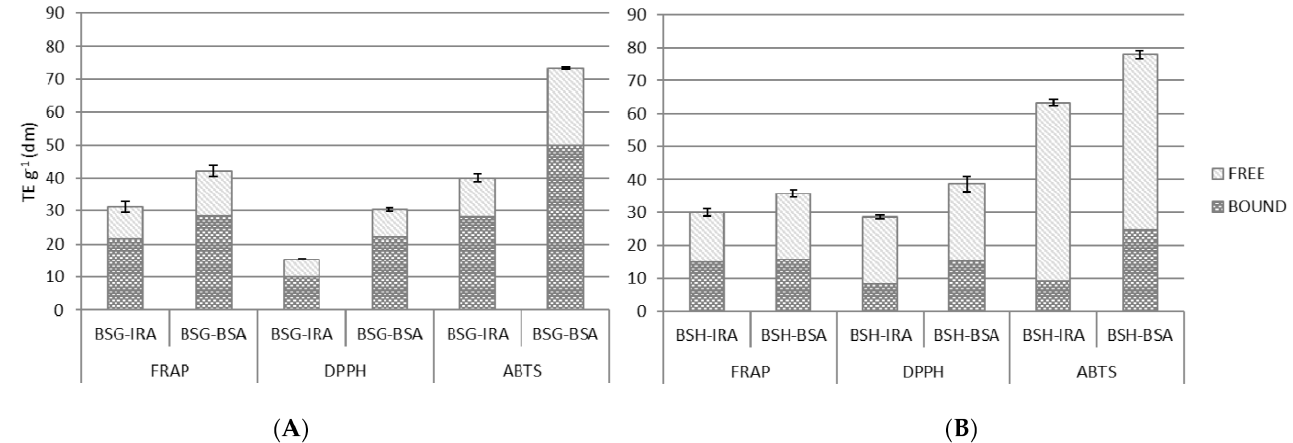
Figure 2. Antioxidant activities of the brewing spent grain, BSG ( A ) and brewing spent hop, BSH ( B ) samples (TE g − 1 dm). n = 3; IRA = Imperial red ale; BSA = Belgian strong ale; TE = Trolox equivalent, dm = dry matter. Different letters and symbols in each column graph denote significant differences between samples ( p ≤ 0.01).